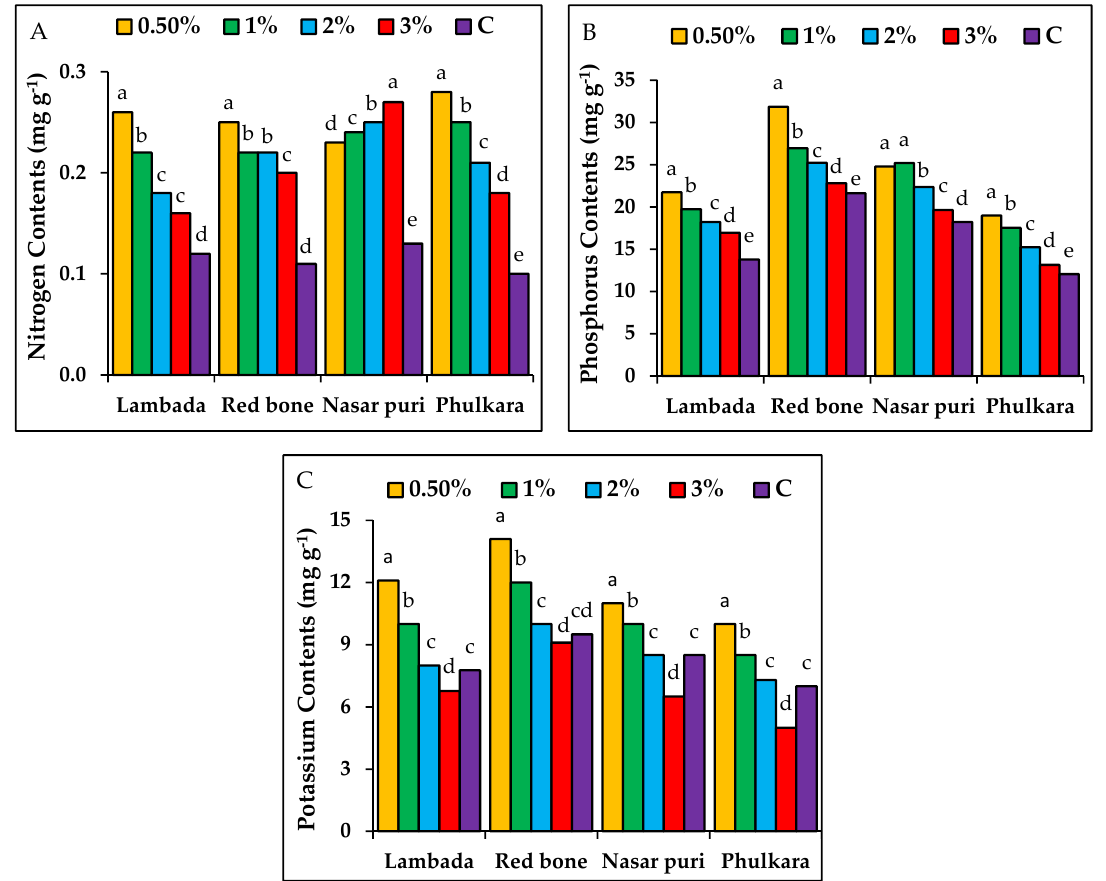
Figure 8. Nitrogen ( A ), phosphorus ( B ) and potassium ( C ) contents per g dry biomass in onion cultivars as affected by foliar application of 0 (C = control), 0.5, 1, 2, or 3% seaweed extract. Values are means of nine replicates ± standard error. Means with different letters are significantly different from each other compared by LSD at p ≤ 0.05.